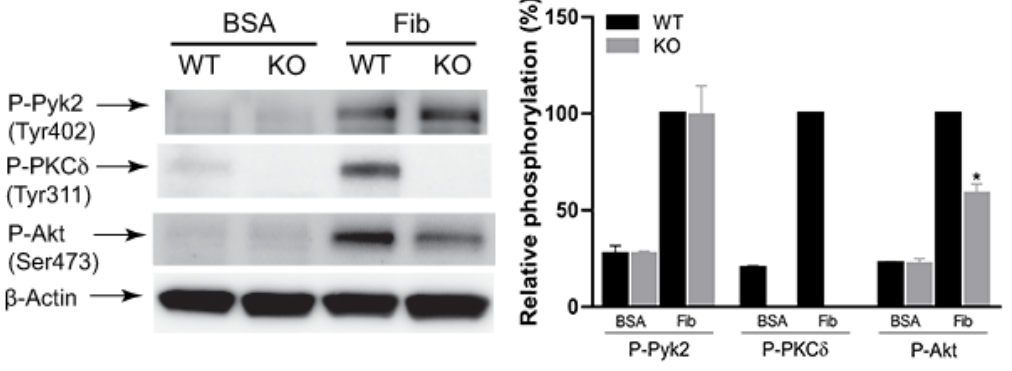
Figure 3. The effect of PKCδ on Pyk2 and Akt phosphorylation by αIIbβ3-mediated outside-in signaling. Washed platelets from PKCδ -/- mice and PKCδ +/+ littermates were plated on either BSA (5 mg/mL) or fibrinogen (100 μg/mL) for 45 min and probed with anti-phospho-Pyk2 (Tyr402), anti-phospho-PKCδ (Tyr311), anti-phospho-Akt (Ser473) or anti-β-actin antibodies by western blotting. The blots are representative of three experiments and are mean ± SE. * p < 0.05.